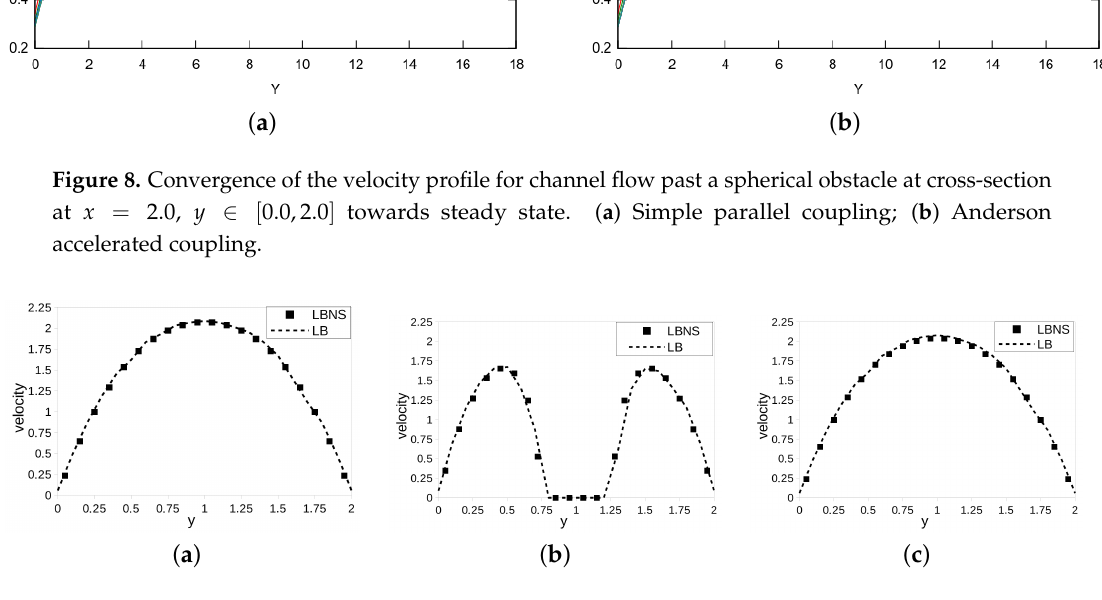
Figure 9. Velocity profile at different cross-sections for channel flow past a spherical obstacle obtained from LB and LBNS simulations. ( a ) ( 0.5, y ,1.0 ) ; ( b ) ( 1.5, y ,1.0 ) ; ( c ) ( 3.0, y ,1.0 ) , y ∈ [ 0,2.0 ]